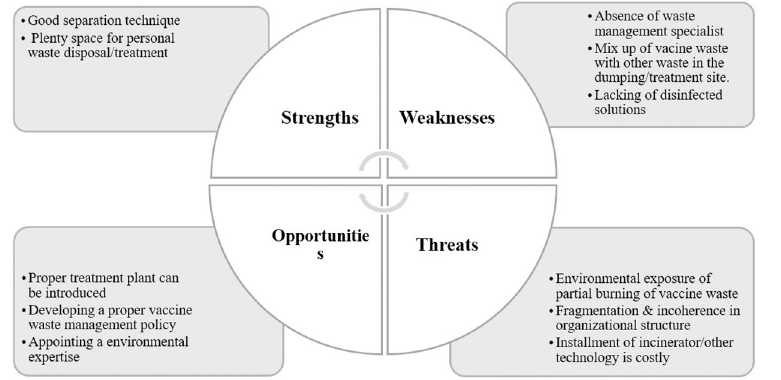
Fig 3. SWOT analysis for COVID-19 vaccine waste management in the